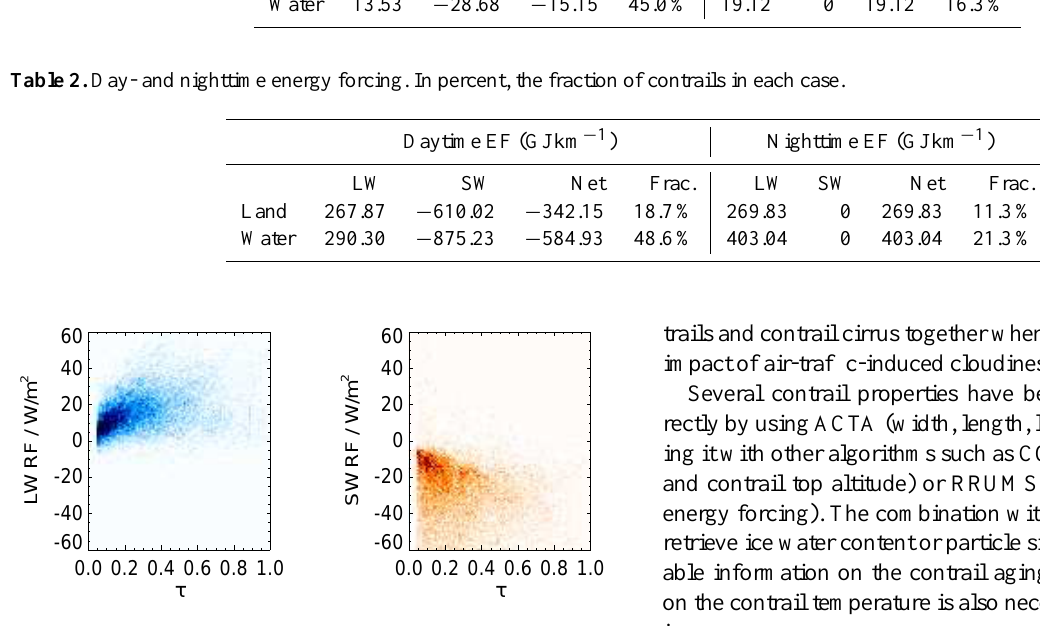
Figure 13. Radiative Forcing vs. τ . Red: SW; blue: